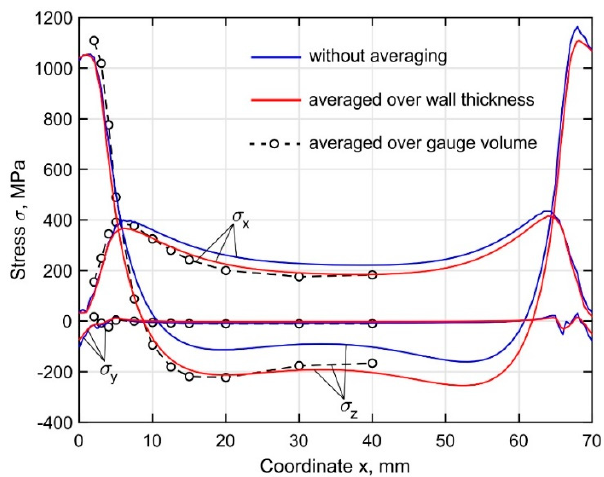
Figure 13. Distribution of the residual equivalent plastic strain near the ends of the buildup corresponding to ( a ) the start and ( b ) end of the pass depositing.